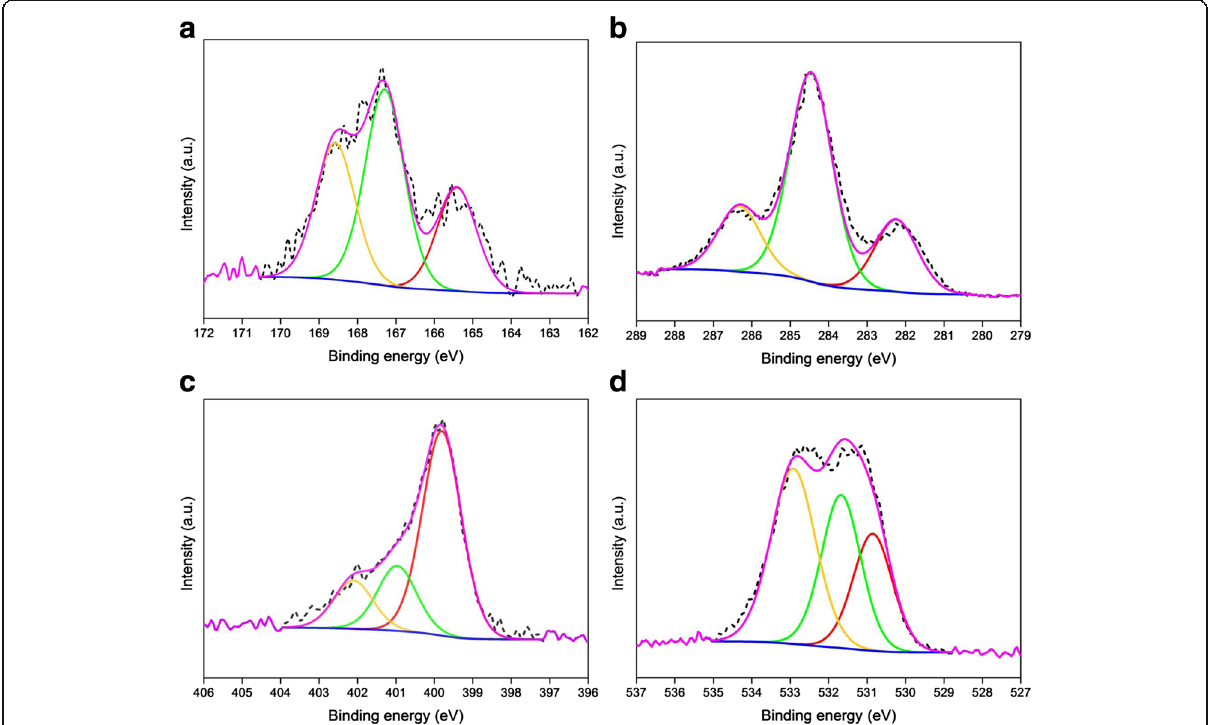
Fig. 3 XPS core-level spectra of PPy-rGO nanocomposite and corresponding deconvolutions of a S2p, b C1s, c N1s and d O1s states. Dotted lines show raw data, and solid lines are fitting